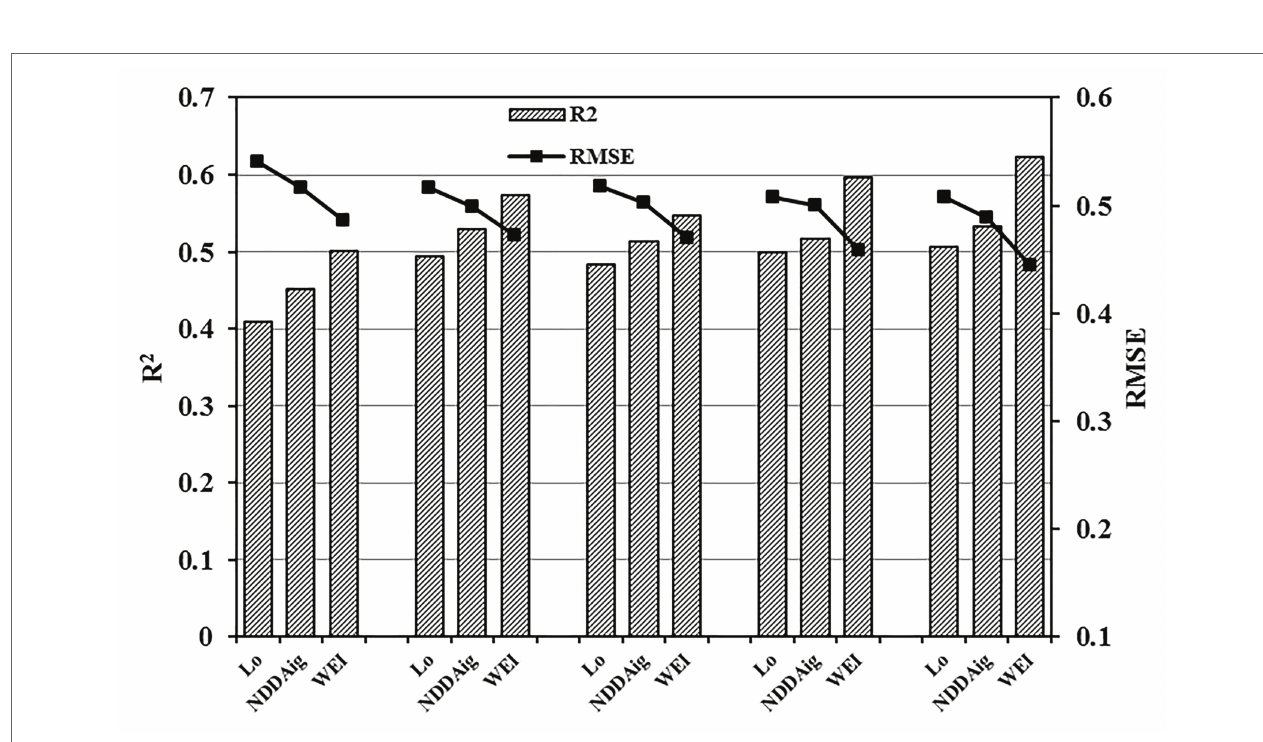
FIGURE 7 | Comparisons of the predictive abilities of Lo, NDDAig, and WEI within five zenith angle ranges ( − 60–60 ° , − 60–0 ° , 0–60 ° , − 20–20 ° , and − 20–10 ° ) with respect to WUE ( n =